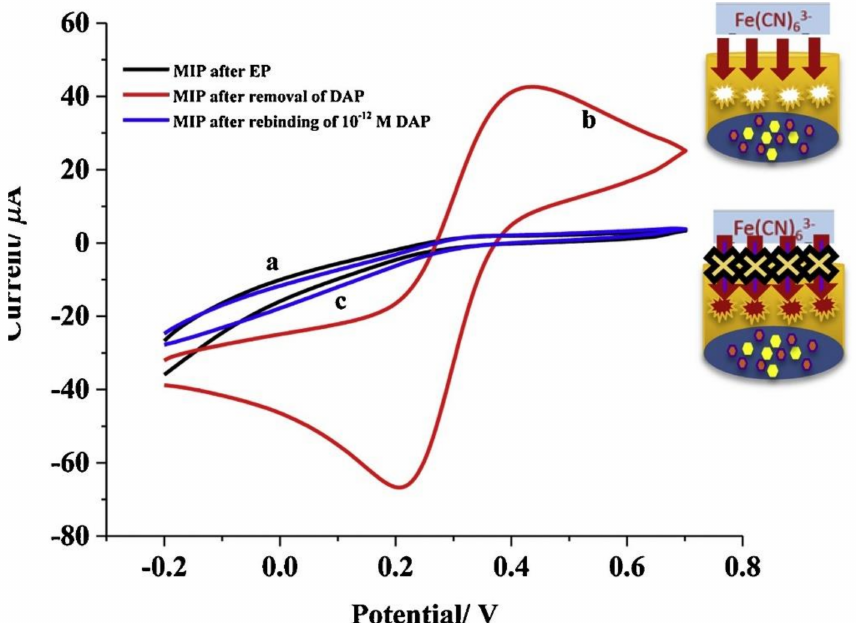
Figure 5. Cyclic voltammograms of ( a ) MIP/Au-Pt NPs/GCE after MIP synthesis ( b ) after removal of